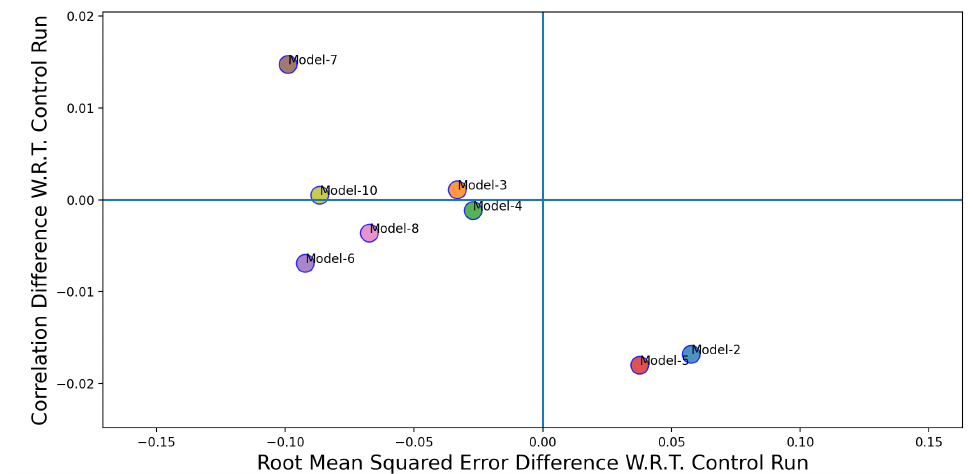
Figure 11. Improvement over control run for Support Vector Machine. The x-axis represents the difference between the RMSE values for the control run and the Twitter-based models. The y-axis represents the difference between the correlation coefficient values between the control run and the Twitter based models.